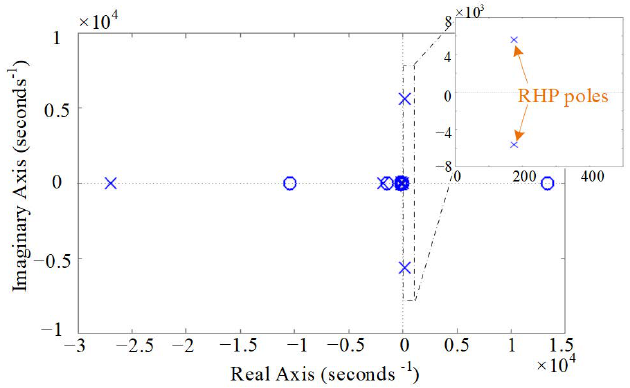
Figure 6. Pole-zero map of G icq_ cl ( s ).